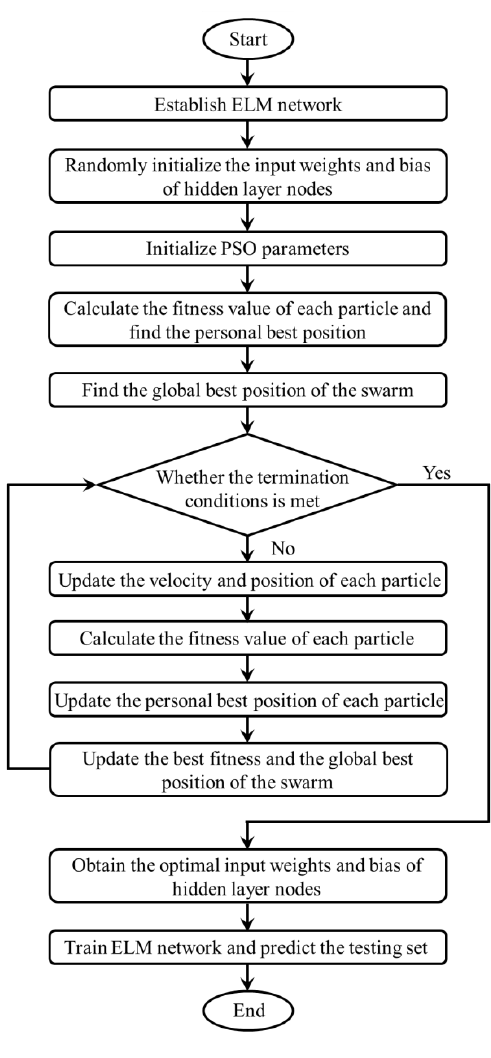
Figure 6. Flowchart of PSO-ELM Algorithm.